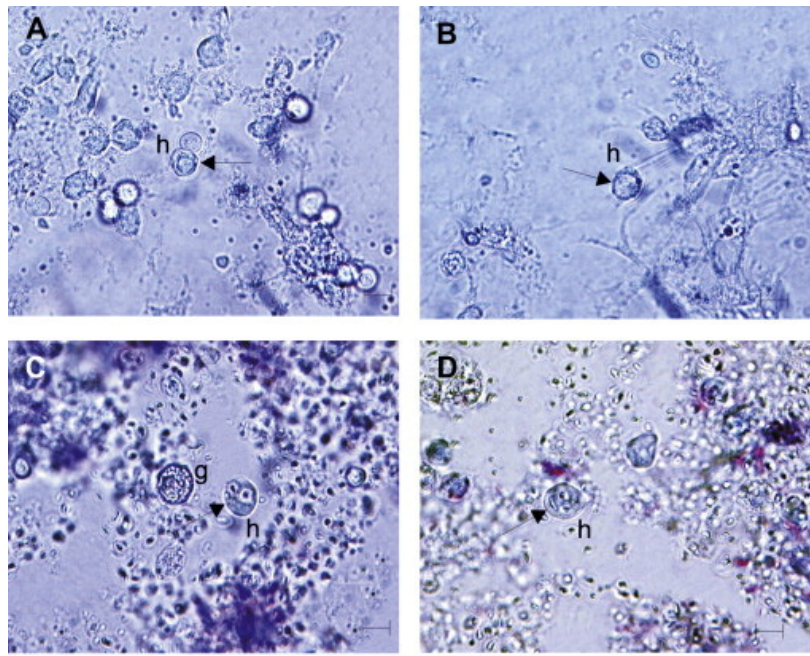
Figure 3. Hyalinocytes endowed with phagocytic capacity, and incorporate yeast cells (arrow) ( A , B ) or Zymosan cells ( C , D ) in a study conducted on Carcinus aestuarii (Crustacea, Decapoda) [13]; g—granulocytes, h—hyalocytes.